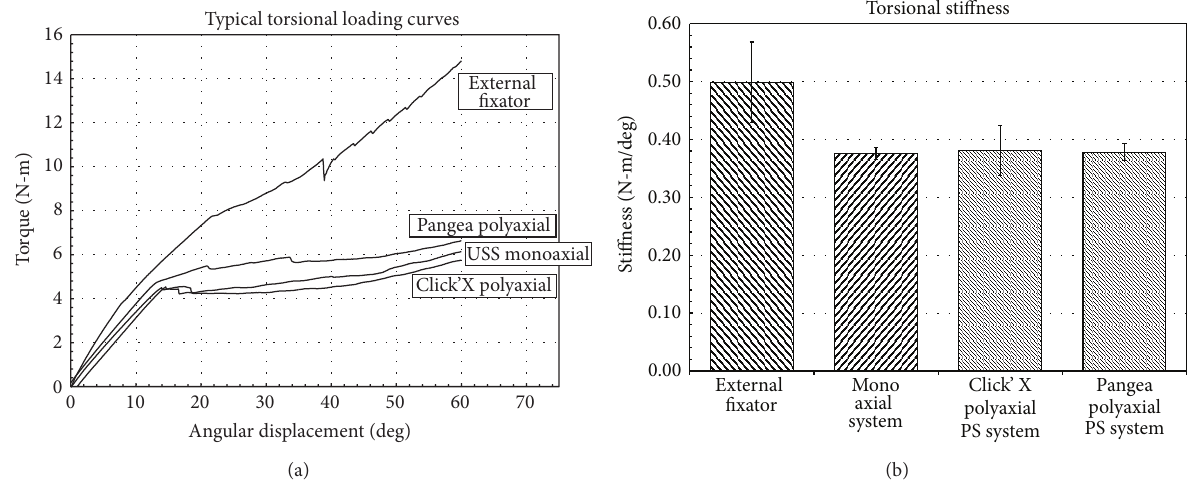
Figure 5: Typical torsion loading curves which show that the external fixator is stiffer than the pedicle screw systems.